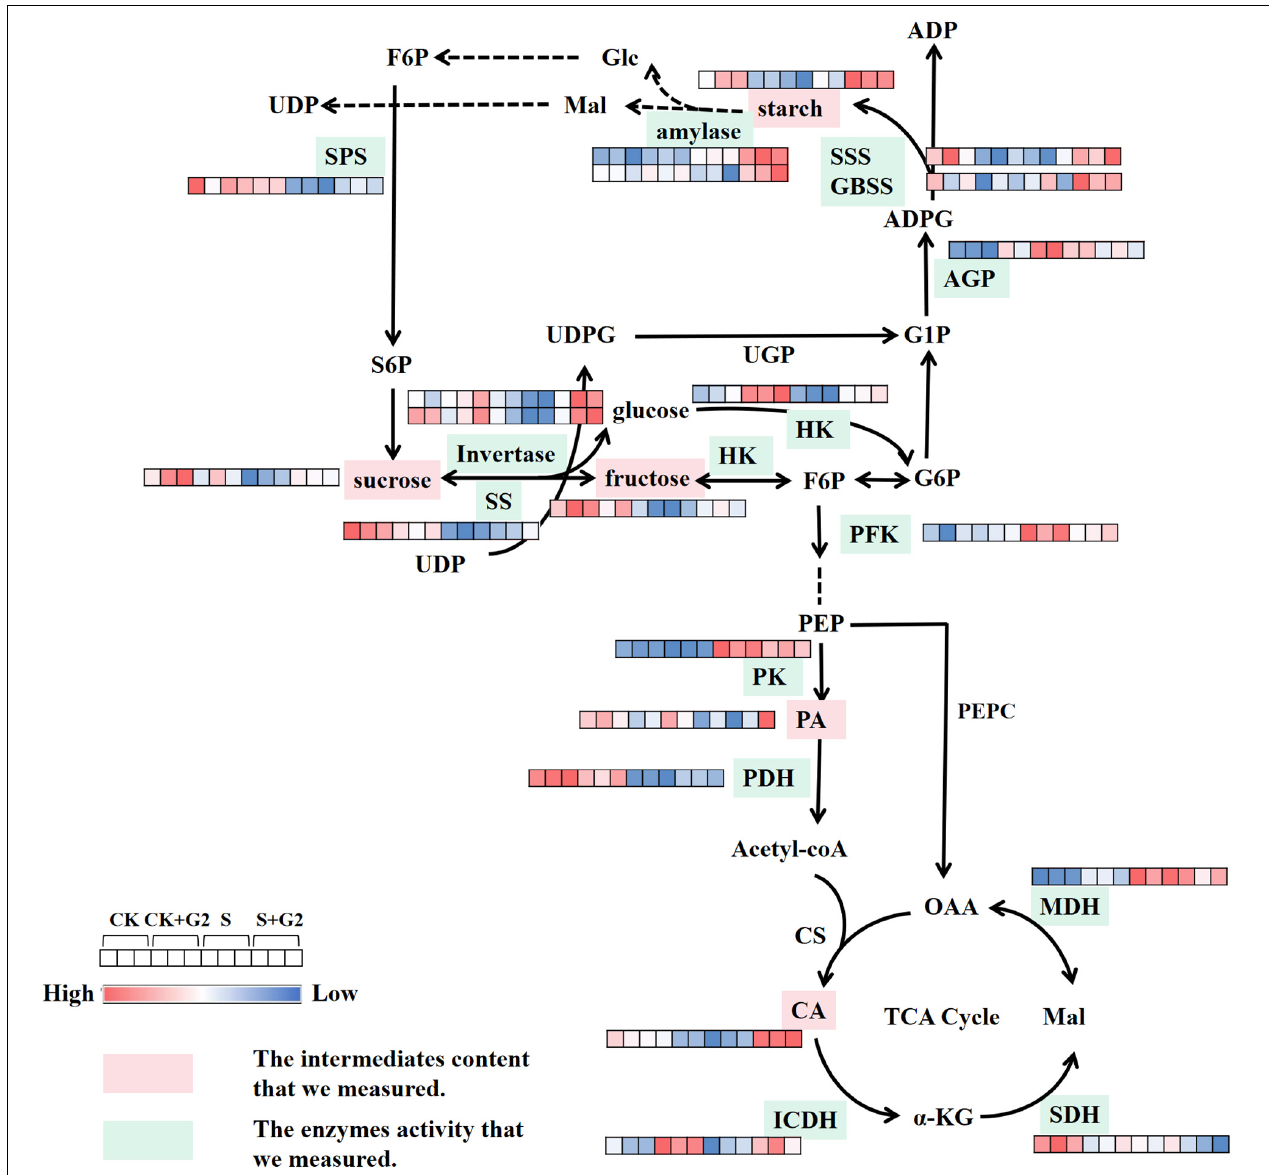
FIGURE 8 | A figure of the mechanism by which B. cereus G2 improves the salt tolerance of G. uralensis by regulating enzymes and intermediates related to carbohydrate metabolism. CK, control group; S, salt stress group; CK + G2, control combined with the G2 group; S + G2, salt stress combined with the G2 group. SPS, sucrose-phosphate synthase; SS, sucrose synthase; AGP, ADP-glucose pyrophosphorylase; GBSS, granule-bound starch synthase; HK, hexokinase; PFK, phosphofructokinase; PK, pyruvate kinase; PA, pyruvate; PDH, pyruvate dehydrogenase; CA, citrate; ICDH, isocitrate dehydrogenase; SDH, succinate dehydrogenase; MDH, malate